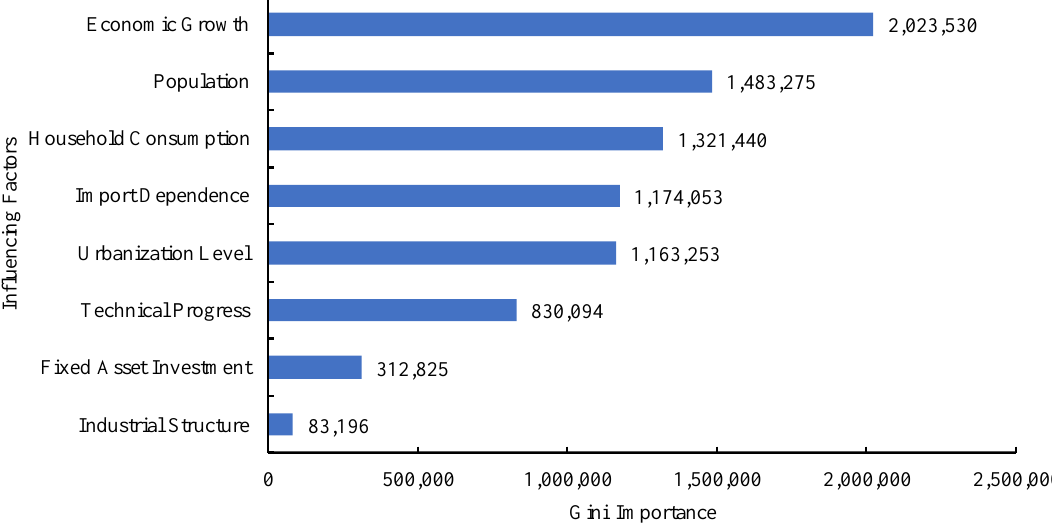
Figure 7. The Gini Importance value of each influencing factor of natural gas consumption. Figure 7 is the Gini Importance of each variable calculated from the random forest model.